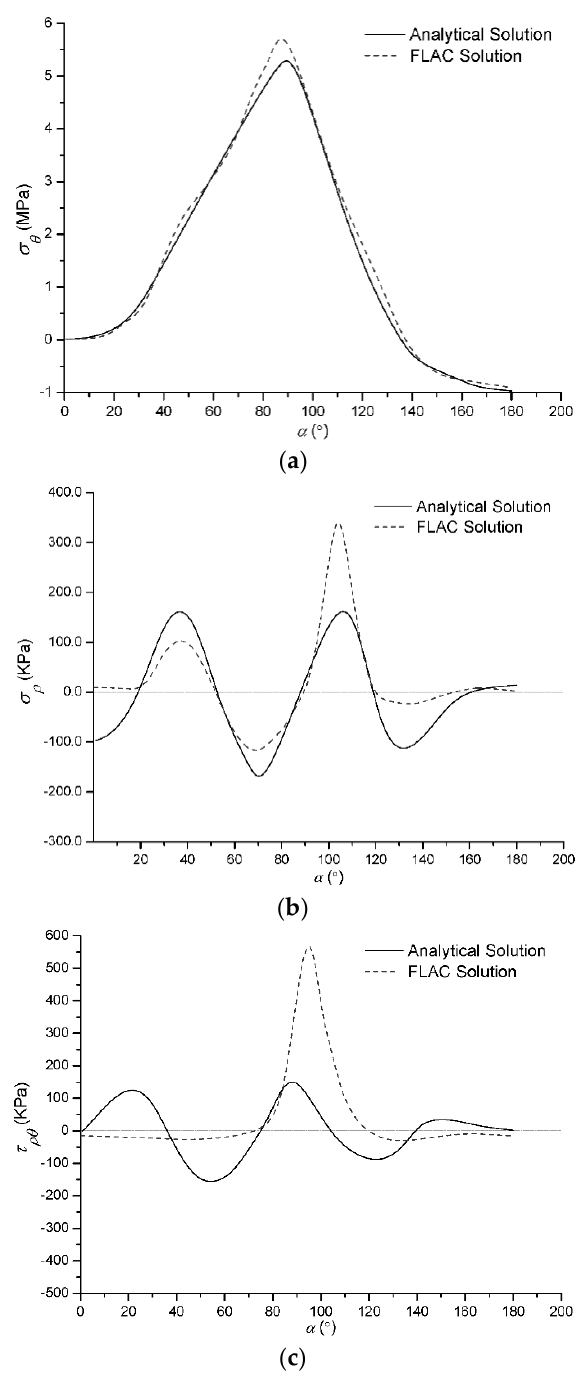
Figure 3. Circumferential stress along the rock – lining interface ( a ) from the lining side ( b ) from the rock side.